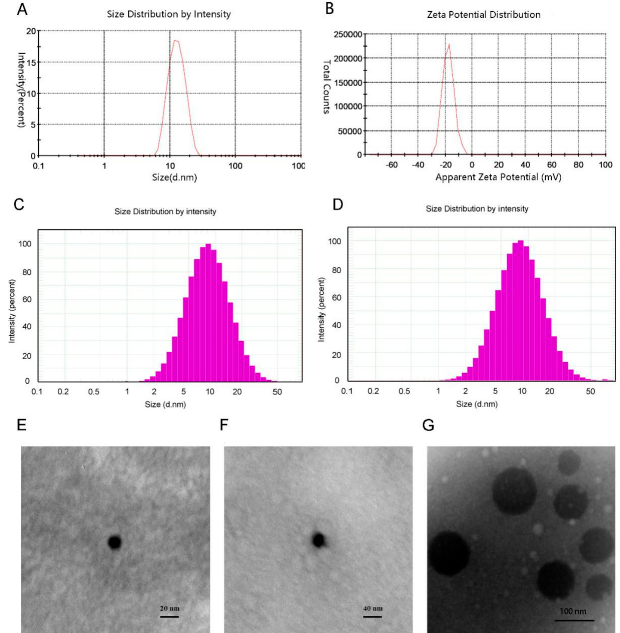
Figure 2. ( A ) Micelle size and size distribution of DS-M. ( B ) Zeta potential of DS-M. ( C , D ) Histograms representing micellar size distribution of drug-free micelle ( C ) and drug-loaded micelle ( D ). ( E–G ) Transmission electron microscopic (TEM) image of blank micelle ( E ), of DS-M ( F ), and of phospholipid ( G